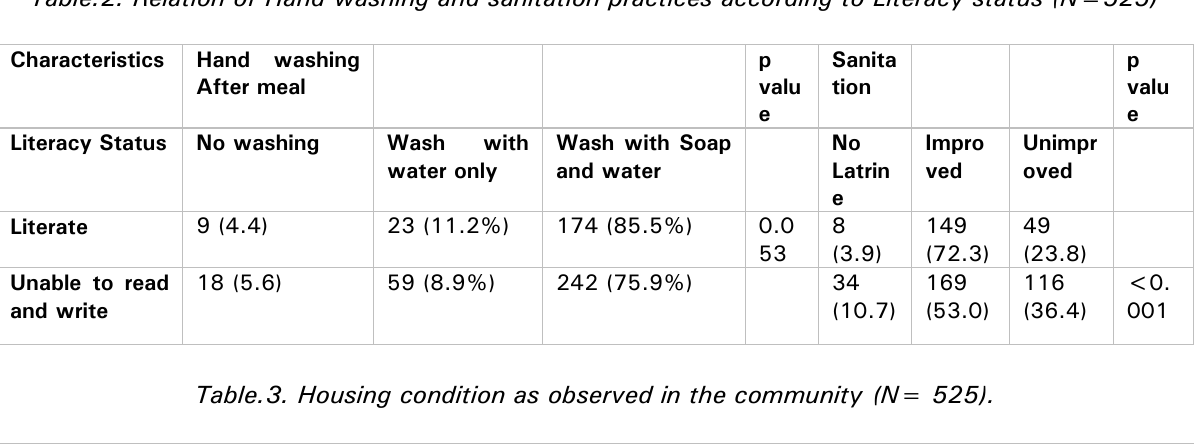
Table.2. Relation of Hand washing and sanitation practices according to Literacy status (N=525)